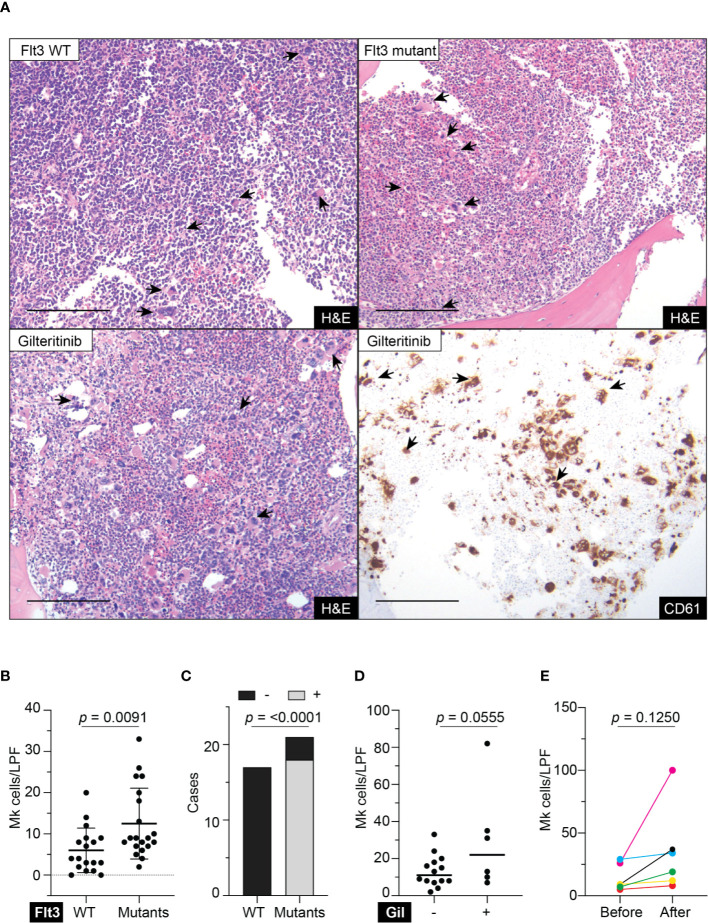
Megakaryocytic profile in acute myeloid leukemia patients. (A) Top panel showing H&E stains of representative trephine bone marrow biopsies from Flt3 wild type and mutant acute myeloid leukemia patients. Lower panel showing sections from the same Flt3 mutant patient showing in the upper right at 1 month following gilteritinib treatment. CD61 immunohistochemistry highlight megakaryocytes scattering in the marrow. H&E, hematoxylin & eosin; scale bar = 100 μm; arrows indicate representative megakaryocytes. (B) Quantification of megakaryocytes in the marrow of acute myeloid leukemia patients. Biopsies prior to gilteritinib treatment were evaluated in the gilteritinib-treated patients. (N = 38; Mk, megakaryocytes; LPF, low power field at 100× magnification). (C) Bar graph showing distribution of midostaurin treatment between Flt3 wild type and mutant group. – indicates without midostaurin, + indicates receiving midostaurin, WT, wild type. (D) Scattered plot representing megakaryocytes in the marrow of Flt3-mutated acute myeloid leukemia patients treated with or without gilteritinib. Each dot representing an individual patient. (Number of Mk was averaged from all available biopsies including pre- and post-gilteritinib treatment, N = 20; Gil, gilteritinib.) (E) Quantification of megakaryocytes in the marrow of Flt3-mutated acute myeloid leukemia patients before and after receiving gilteritinib.